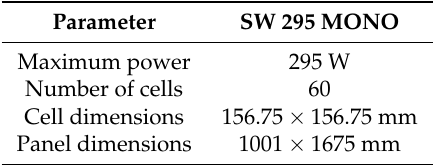
Table 4. Main technical characteristics of the photovoltaic model.